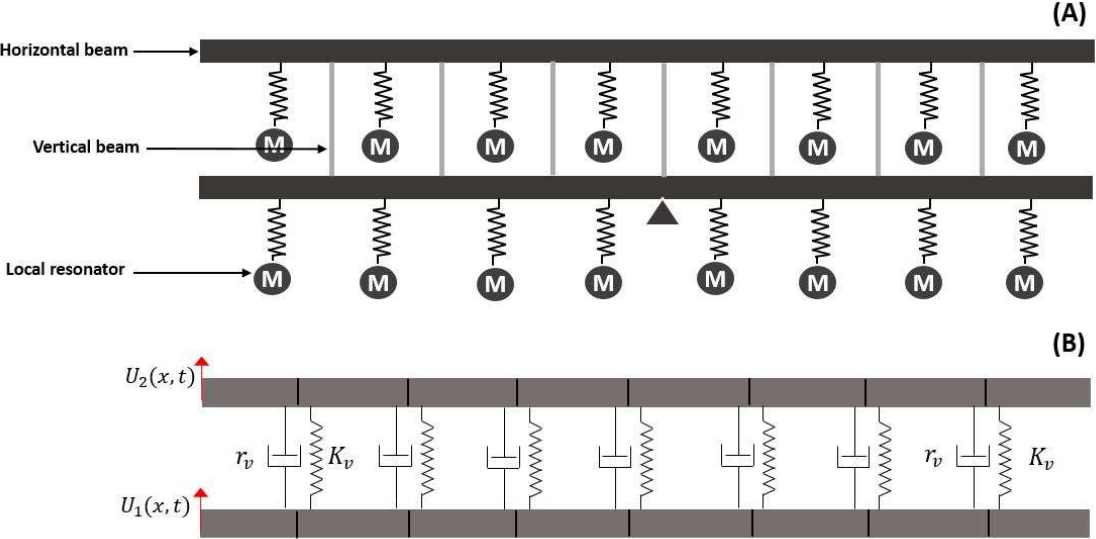
Figure 4. Schematic representation of the model approach to a layered-beam metamaterial structure: ( A ) Double-beam metamaterial structure with 8 local resonators and vertical beams connecting the horizontal beam; ( B ) representative diagram of the interlinking vertical beams, the damping and stiffness applied in the modeling approach for the dynamic displacement of the layered-beam metamaterial structure.